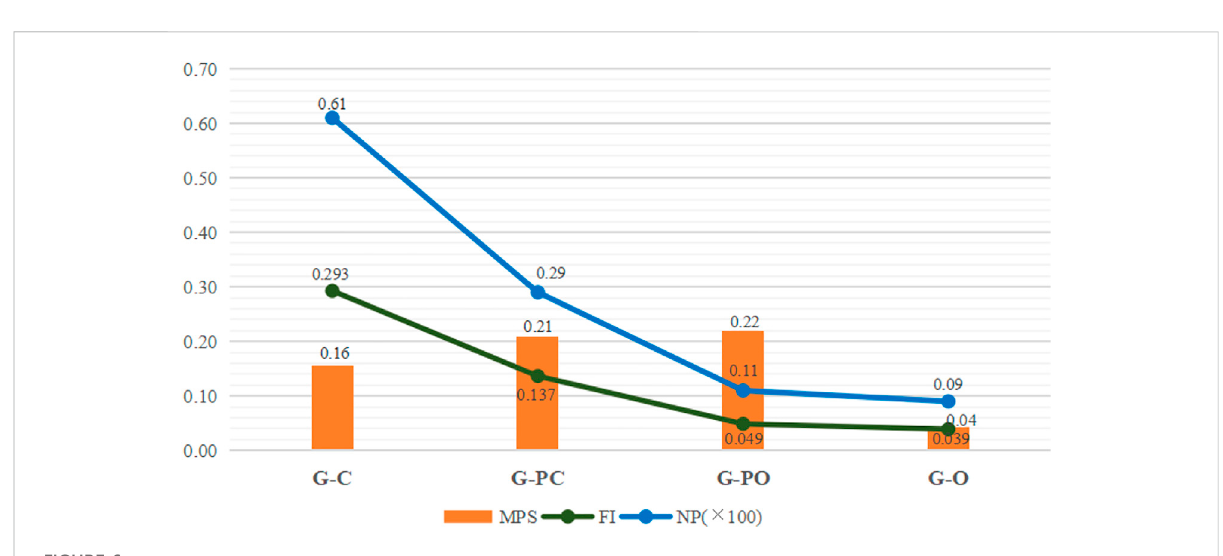
FIGURE 6 Fragmentation assessment of biotope type in G biotope